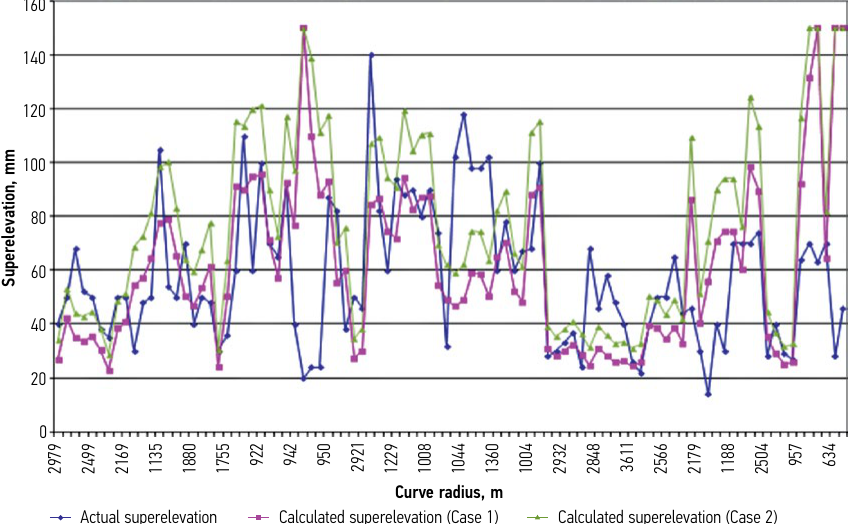
Fig. 3. Superelevation in the curves following the line Kaišiadorys–Kybartai: Case 1 – v = 0.8· v max ; Case 2 – v = 0.9· v